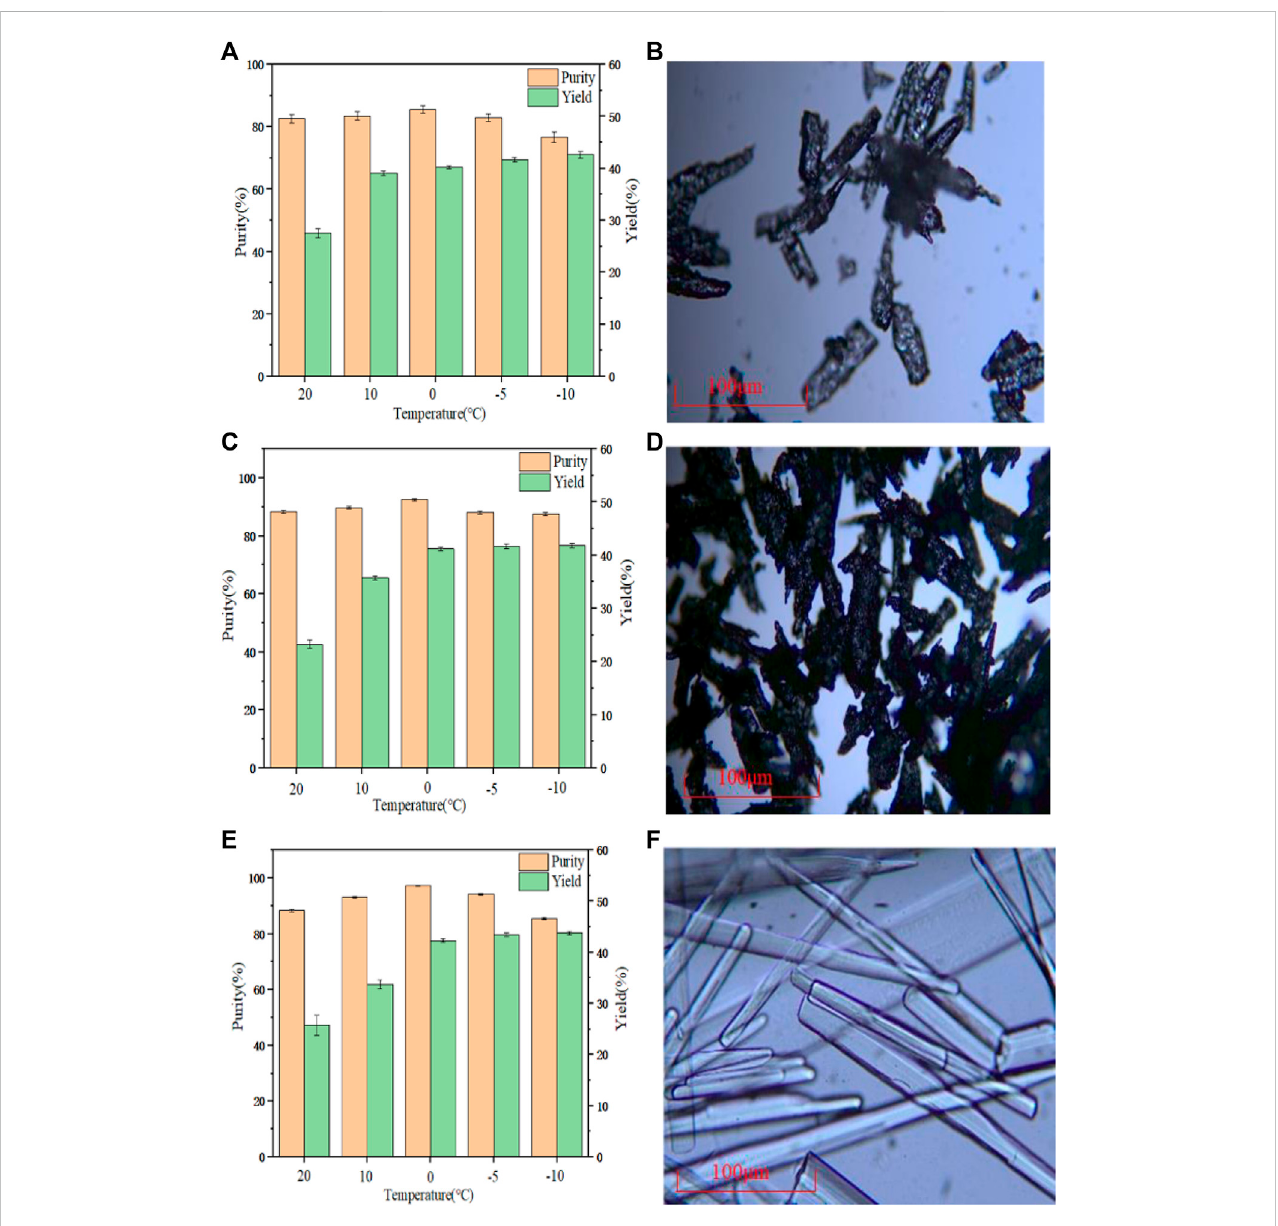
FIGURE 8 (A) Crystallization yield and purity of PHF (B) Microscope image of PHF (C) Crystallization yield and purity of PHDF (D) Microscope image of PHDF (E) Crystallization yield, purity of PHER (F) Microscope image of